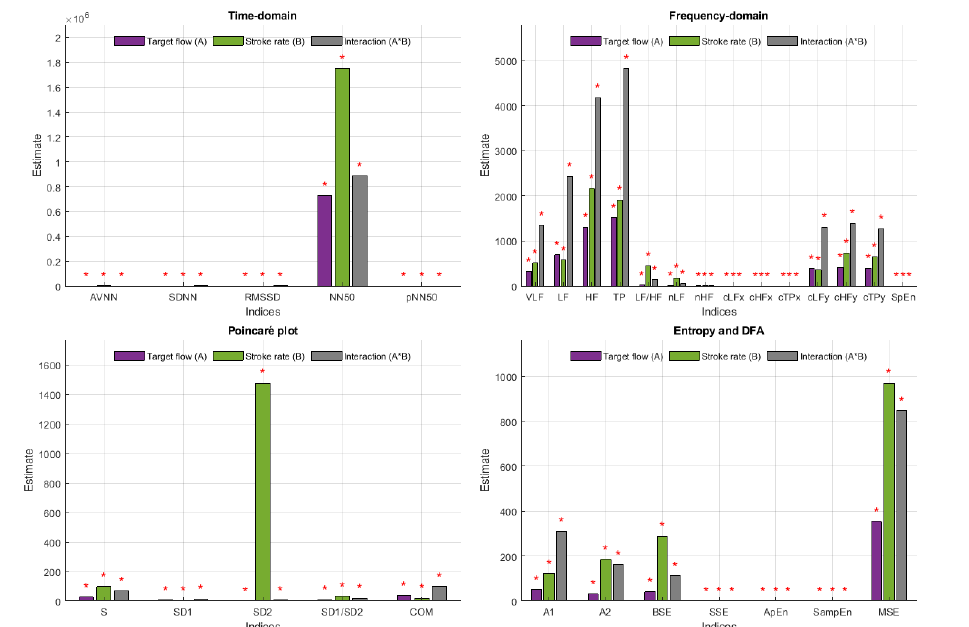
Figure 8. Effect estimates for stroke rate (SR), target flow (TF) and their interaction on each of the indices extracted from pulse rate variability (PRV) measured from the deep palmar arch phantom. Red stars on top of the bars indicate statistically significant